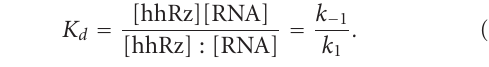
As for AS, the initial dissociation constant ( K d ) is given